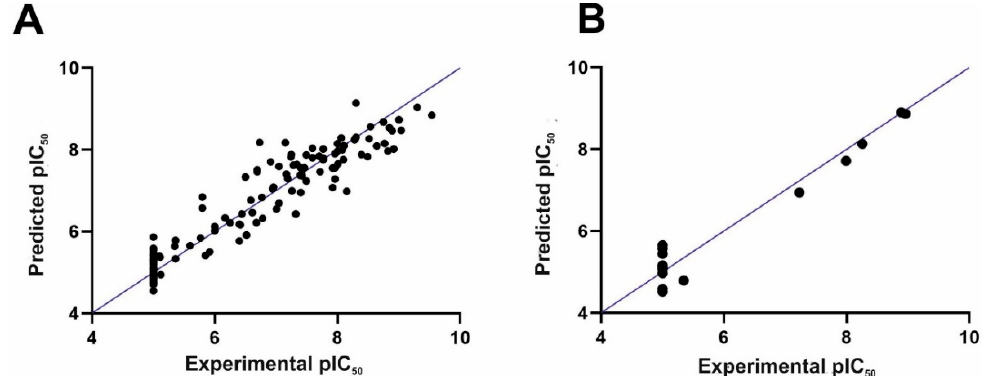
Figure 2. The experimental versus predicted pIC 50 (negative of the base 10 logarithm of the half maximal inhibitory concentration) values for the training set ( A ) and test set ( B ).